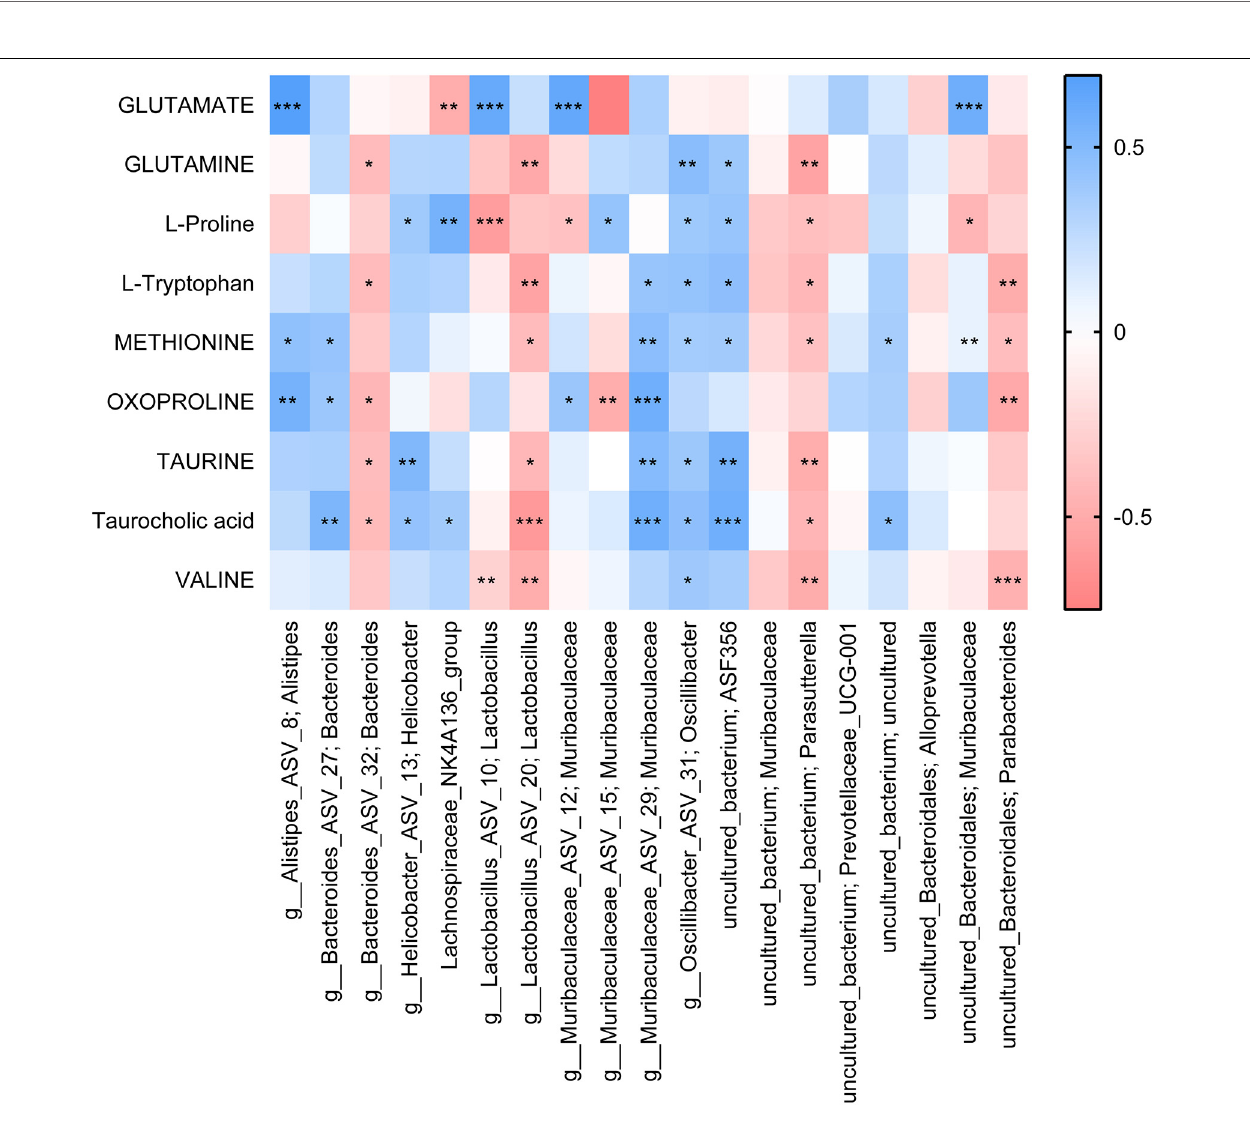
FIGURE 7 | Correlation analysis of differential metabolites with the top 20 gut species. Each block represents a correlation, and the color of the block represents the strength of the correlation. A high absolute value of R-value indicates a strong correlation. * P < 0.05. ** P < 0.01. *** P <